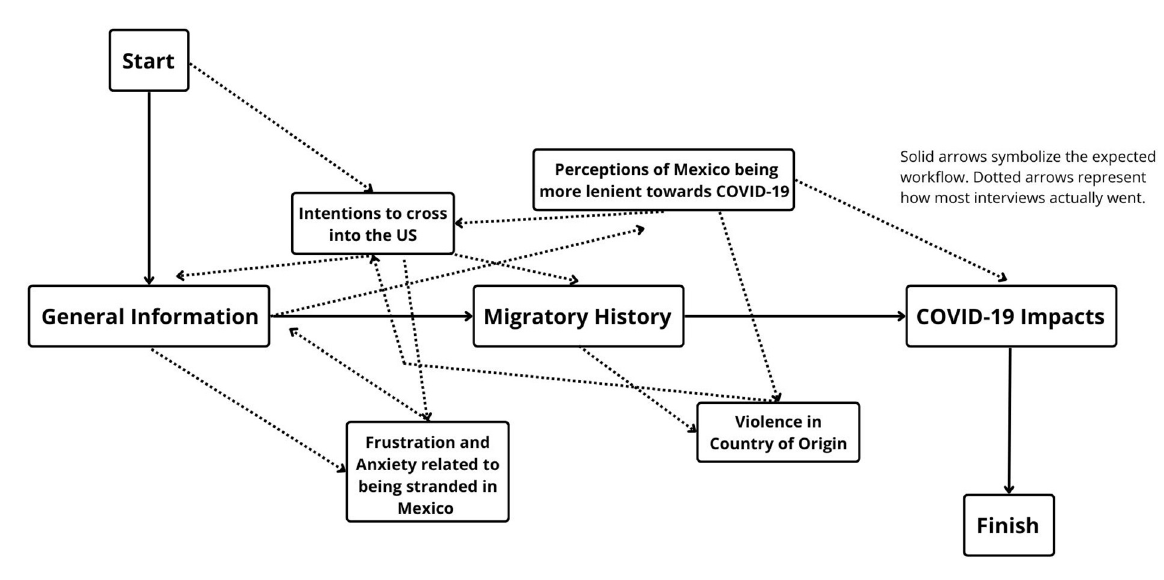
the US by organized groups of Central American immigrants; their clash with US Border and Customs authorities was widely reported, with some of the most conservative news outlets in the US fearing a mass invasion of undocumented migrants (23,